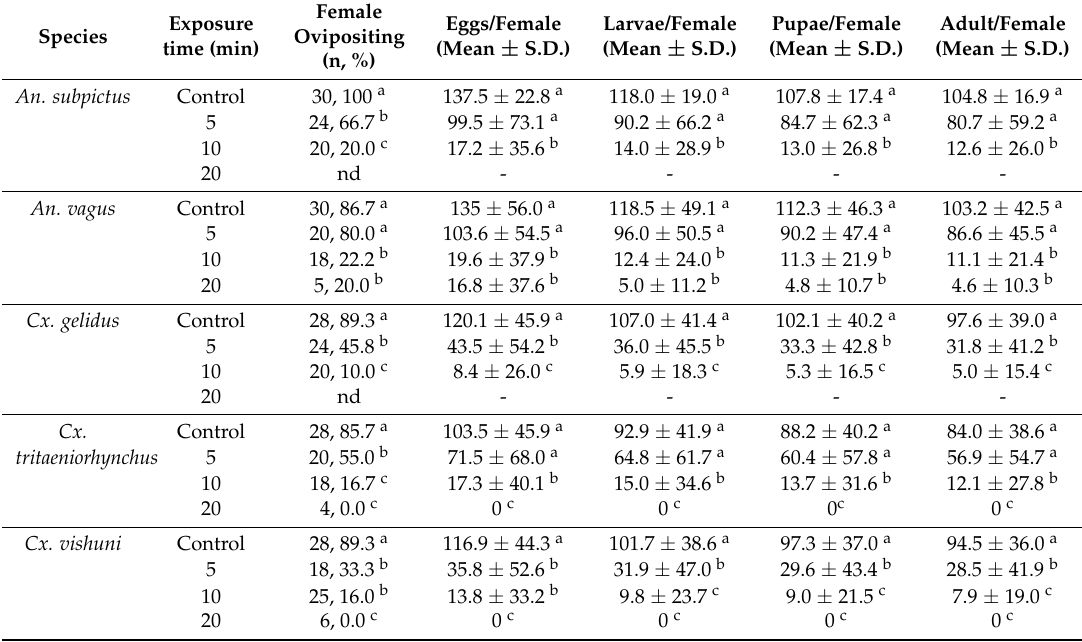
Table 2. Reproductivity of naturally engorged female mosquitoes after, 5, 10, and 20 min exposure to PPF-treated polypropylene sheets (666 mg/m 2